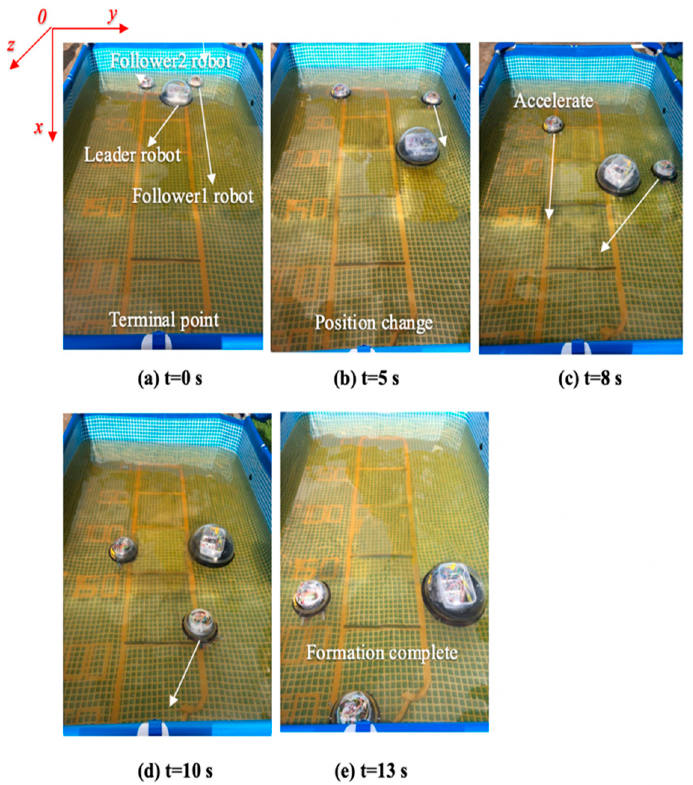
Figure 24. Experimental set up for a multi-robot role interchange.